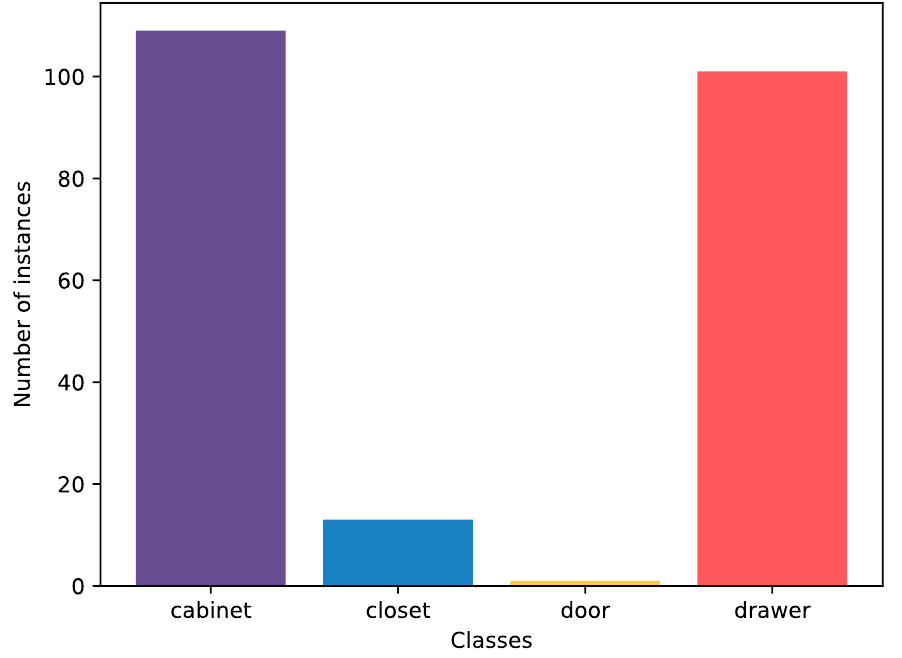
Figure 5. Distribution of object instances per category.